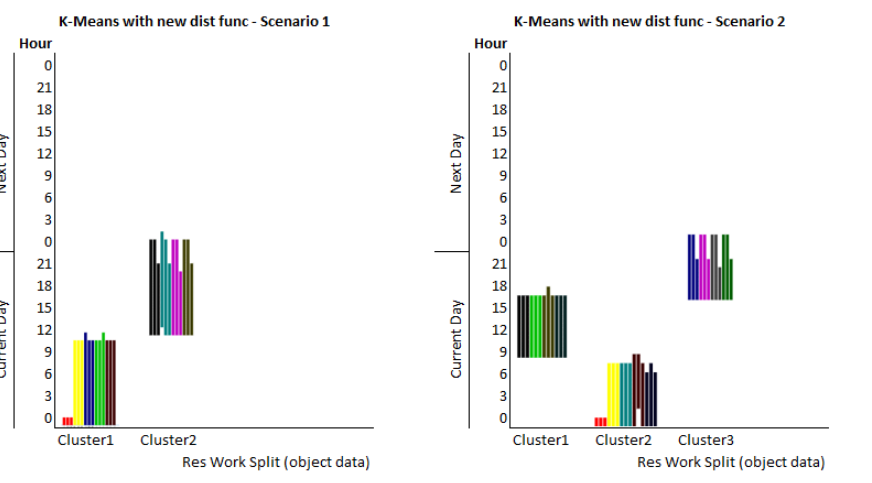
Figure 11. The comparison of clustering by incorporating the new distance